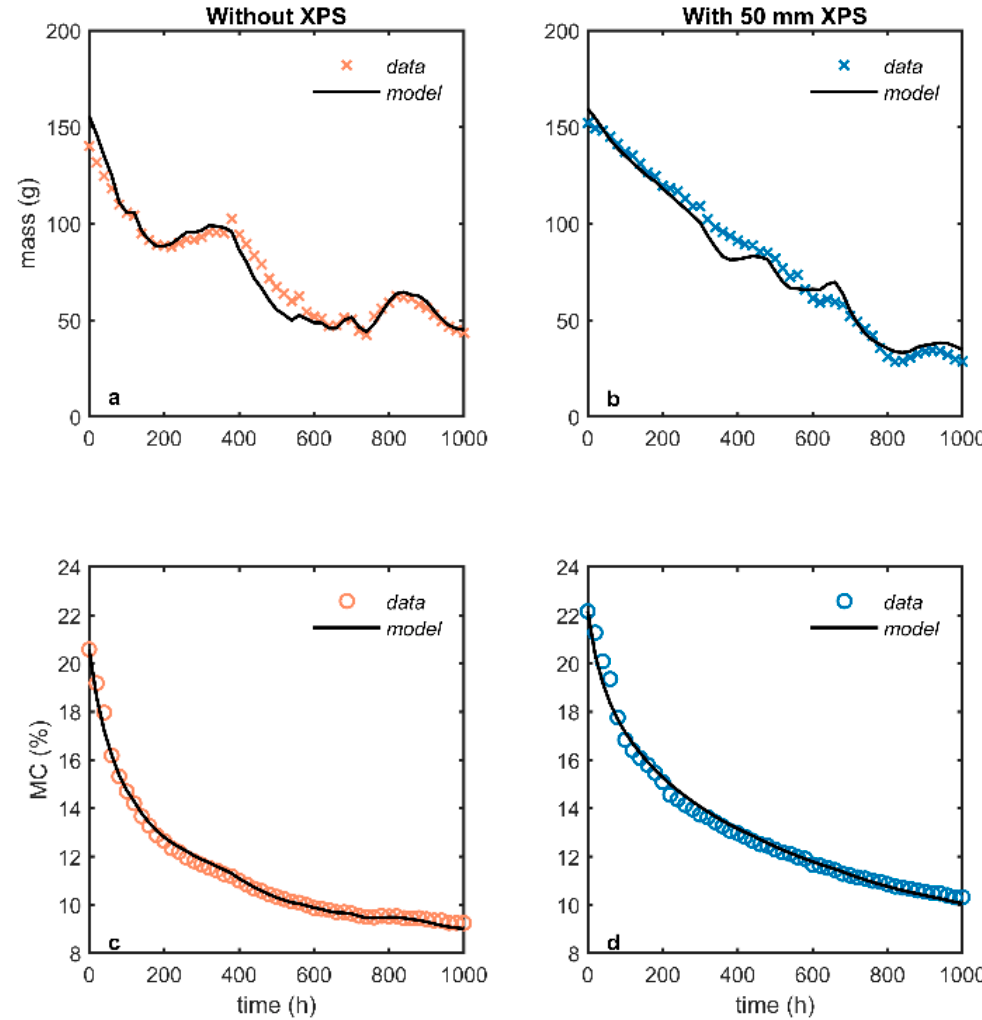
Figure 10. Measurement versus model prediction for walls with painted framing lumber (paint, w / o XPS and paint, w / XPS). Variations in room humidity caused the mass fluctuations. Subfigures ( a ) mass results, and ( c ) MC results, represent the wall without XPS covering the OSB, while ( b ) mass results, and ( d ) MC results, represent the wall with 50 mm XPS insulation covering the OSB.